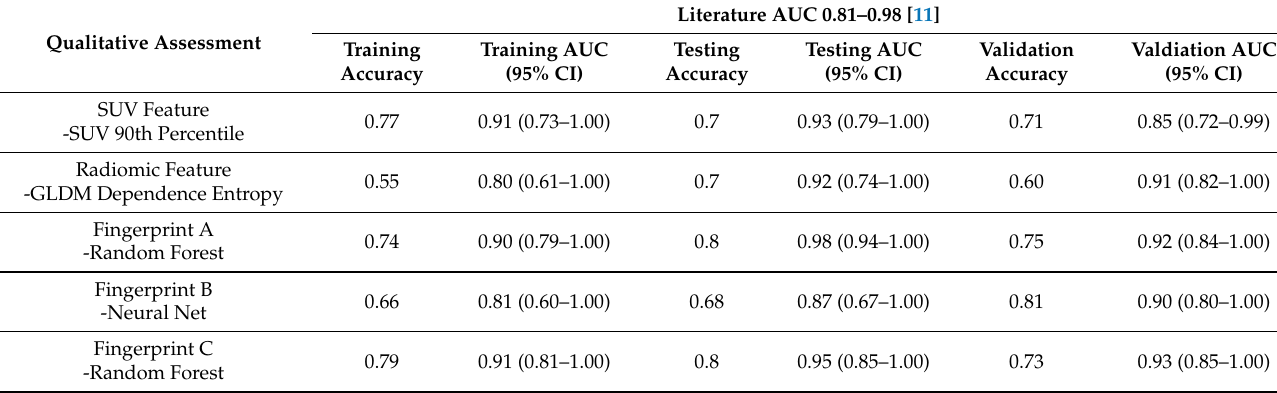
Table 5. A summary of the diagnostic utility of each explored